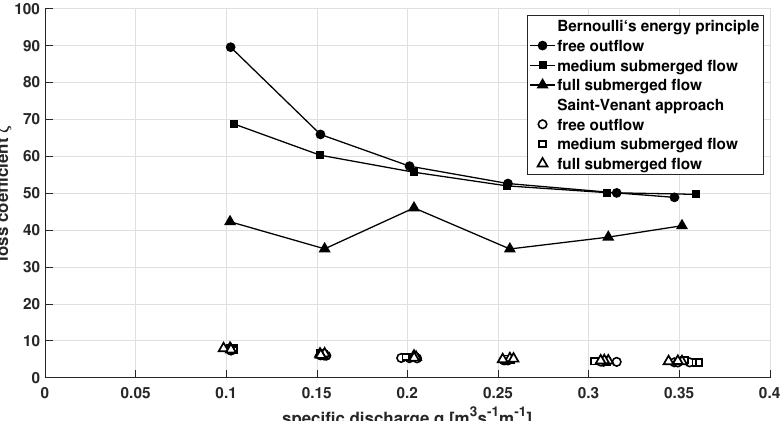
Figure 4. The loss coefficients were determined by evaluating the measurement data from this study with Bernoulli’s energy principle (Equation(6)). The loss coefficient ζ is highly affected by the backwater situation and depends on the flow velocity. Furthermore, Bernoulli’s energy principle overestimates the more reliable results from the Saint-Venant approach (Section